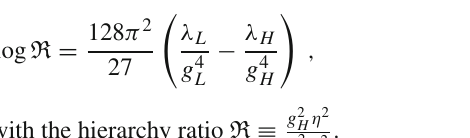
Fig. 4 Effect of the λ LH parameter in the position of the minimum. In the background, a contourplot of the potential V (ϕ,η) is represented for { λ LH = 0 ,λ L = 0 . 001 , g L = 0 . 6 ,λ H = − 0 . 001 , g H = 0 . 6 } , with its minimum ( (cid:14) ). For λ LH < 0, the minimum of the potential is slowly displaced (red curve) towards the diagonal (black line). For λ LH > 0, apartfrom theoriginalminimum,thereisoneadditionallocalminimum on each axis ϕ = 0 ( • ) and η = 0. As one increases λ LH , the central minimum remains at first the global one but its position is displaced towards the ϕ = 0 axis (orange line). As the parameter increases, for λ > λ crit , A ( (cid:4) ), the central minimum turns into a local minimum LH LH instead of the global one (blue line). When λ LH > λ crit , B ( (cid:5) ), the LH central (local) minimum disappears and only the minima at the axes remain